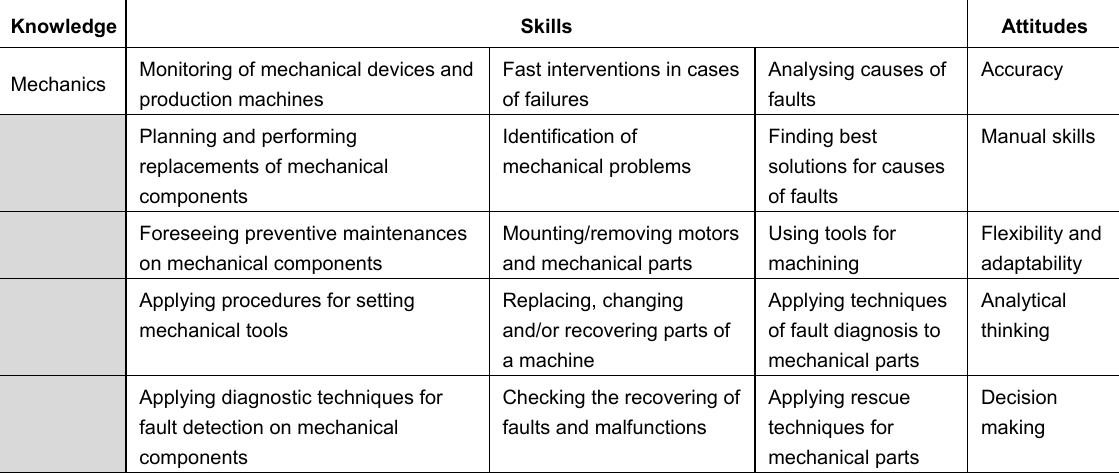
Table 2. Complete KSA model for the worker